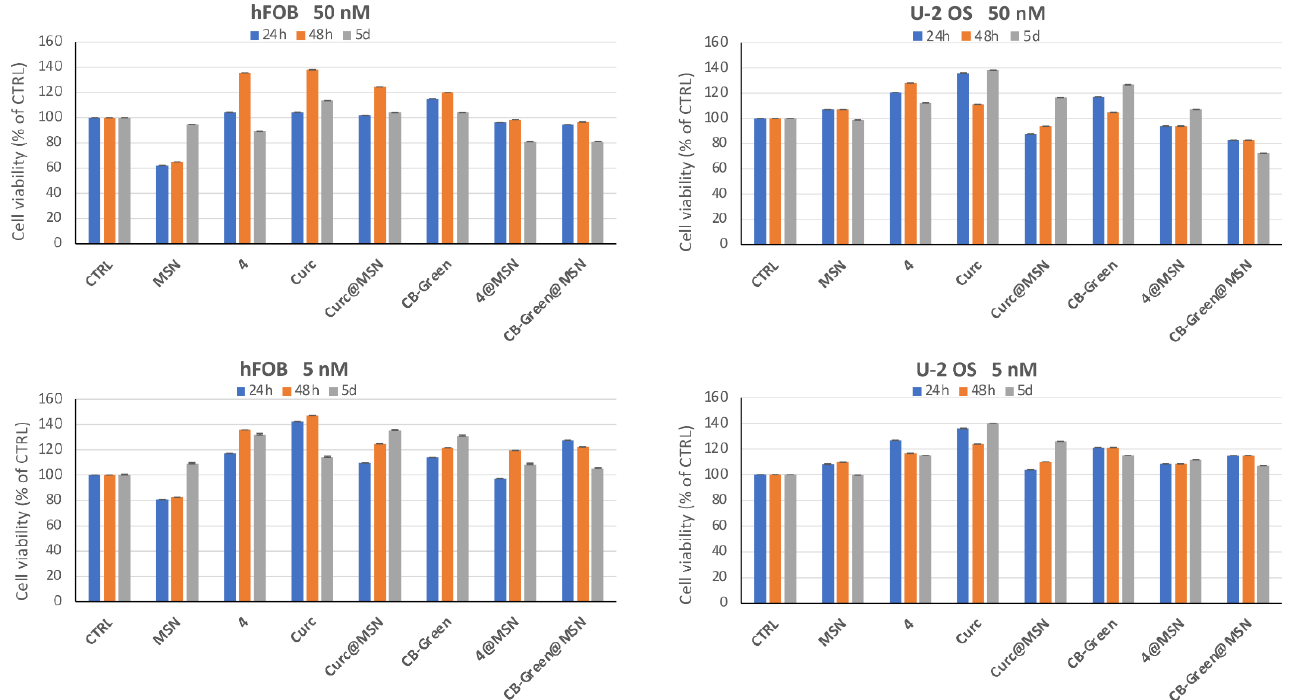
Figure 4. Cell viability test performed on hFOB and U-2 OS cells after 24 h, 48 h and 5 days of incubation with MSN, 4, Curc, Curc@MSN, CB-Green, 4@MSN, CB-Green@MSN molecules